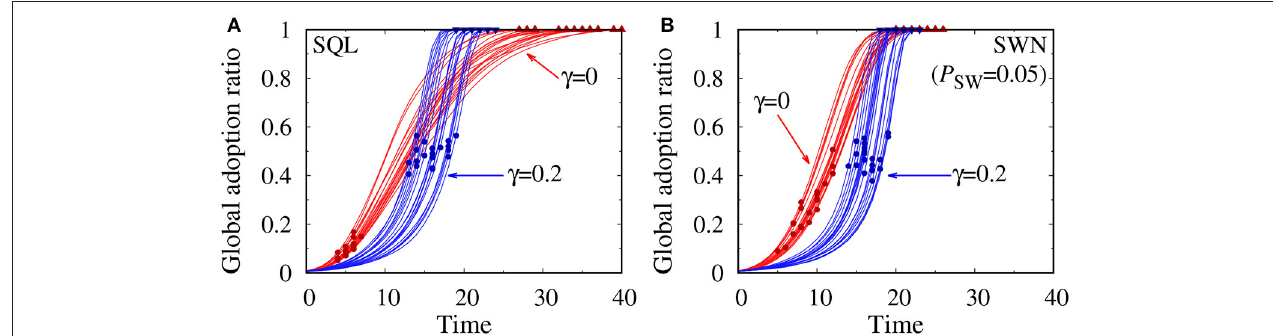
0 and γ 0.2 in SQL (A) and in SWNs with P SW = =